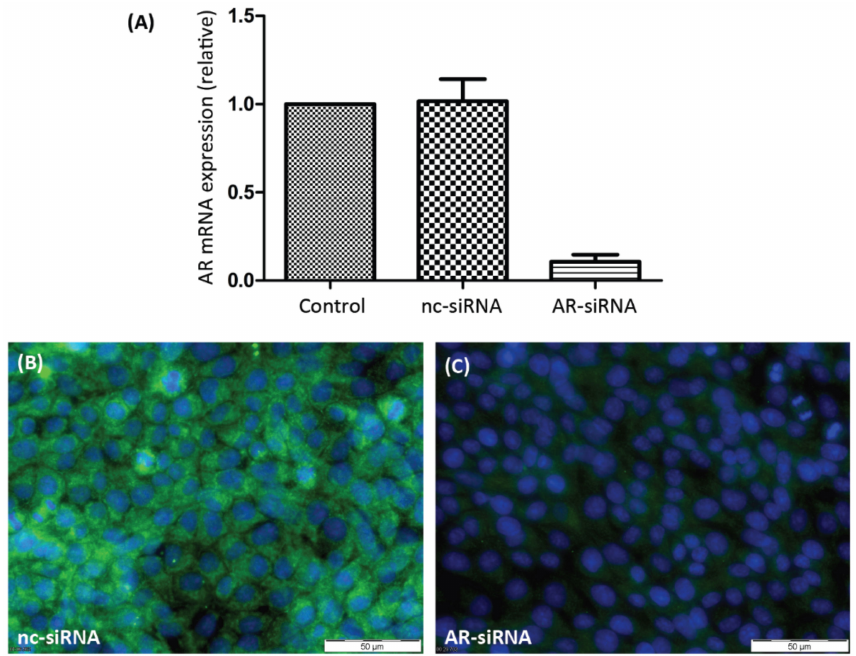
Figure 1. Detection of AR mRNA or protein in PASC1 cells. Cells were treated with either nc-siRNA or AR-siRNA. ( A ) qRT-PCR showing expression of AR-specific mRNA/cDNA. ( B ) Detection of AR protein by immunofluorescence before and ( C ) after silencing AR-specific mRNA expression. Green fluorescence corresponds to AR and nuclei are stained blue.